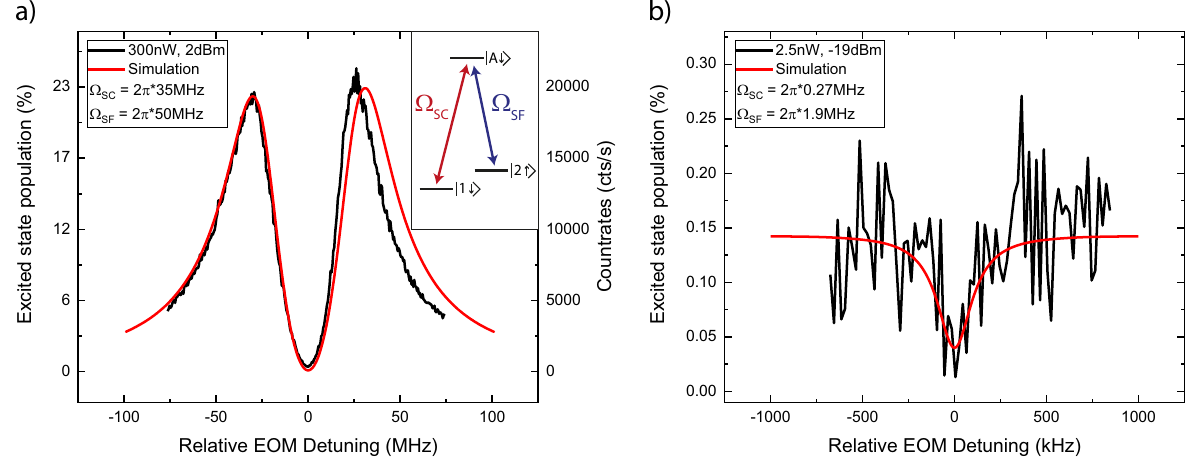
Fig. 4 CPT measurement on a charge stabilised SnV − centre. a CPT measurement on Emitter 2 with 300 nW of total laser power. This measurement is used to relate measured count rate to excited spin state populations of the SnV − centre. The mismatch of the simulation and the data on the high frequency side of the measurement is caused by approaching the edge of the ampli fi cation range of the microwave ampli fi er used, thereby effectively decreasing the sideband laser power. b Measurement of the CPT dip width with lowest possible total laser power, while preserving a reasonable signal to noise ratio. The data is fi tted with a ground state decoherence rate of 64(10) kHz relating to a spin dephasing time of T